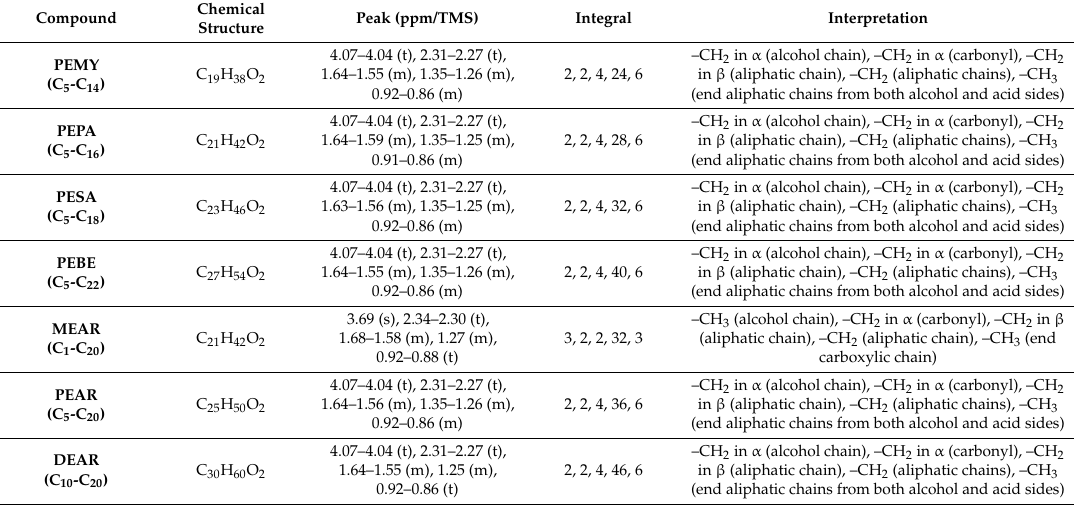
Table 2. List of 1 H Nuclear Magnetic Resonance (NMR) peaks recorded in CDCl 3 from all samples produced, which allows the correct identification of compounds. Tetramethylsilane (TMS) was used as a reference and is assigned the value of 0 ppm. The peak position is reported in the peak section and the coupling in between brackets (s = singlet, t = triplet, m = multiplet). For each peak, the corresponding normalized value is reported in the integral column in the same order as the peak column, while the corresponding groups forming the signals are reported in the interpretation